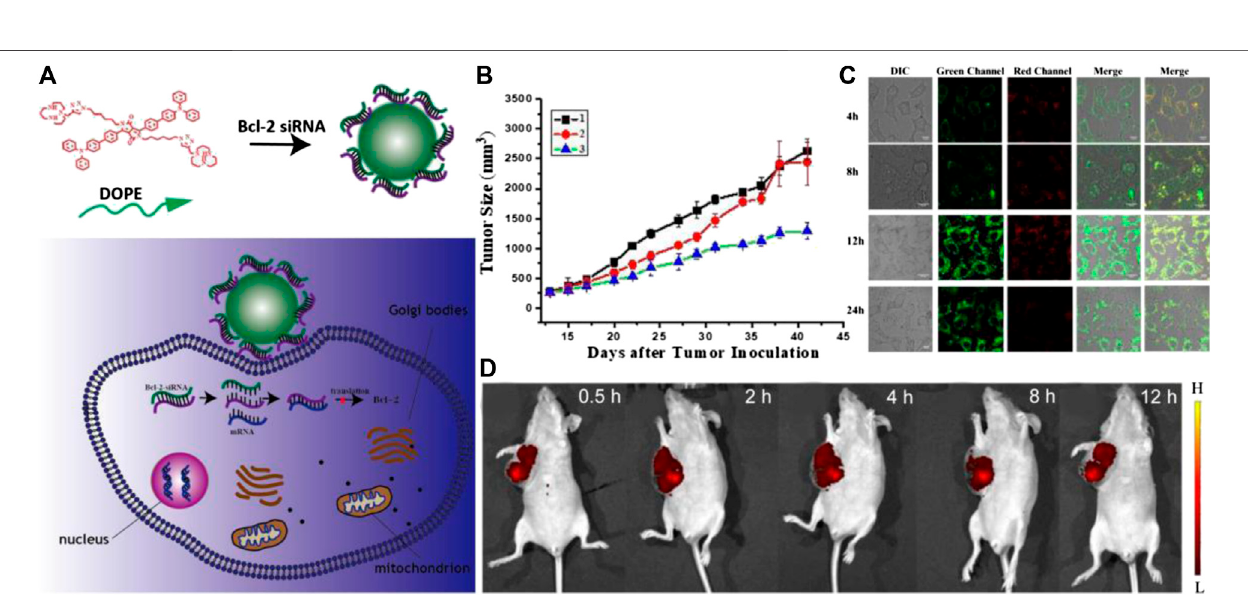
Frontiers in Chemistry |